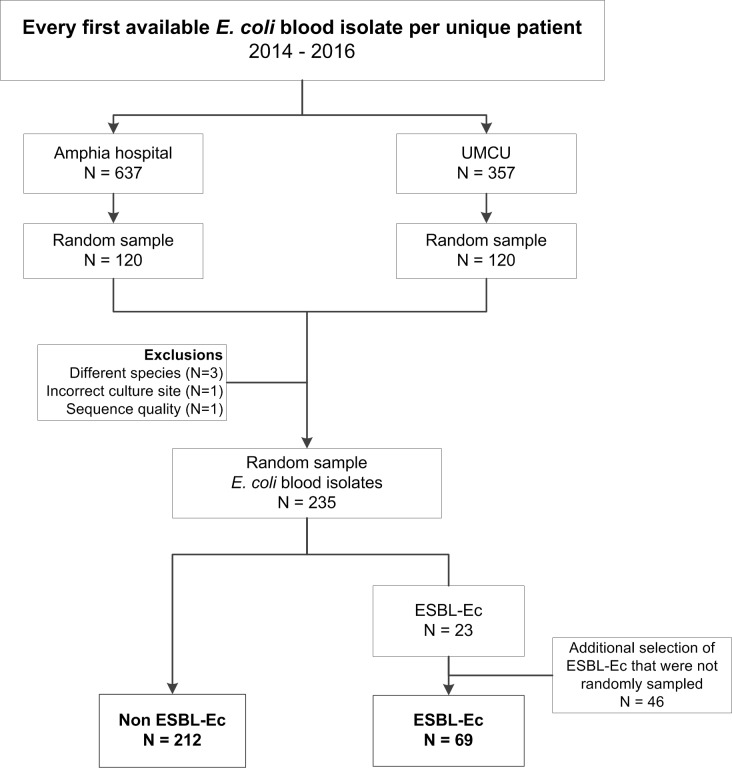
Flowchart of selection of E. coli blood isolates.